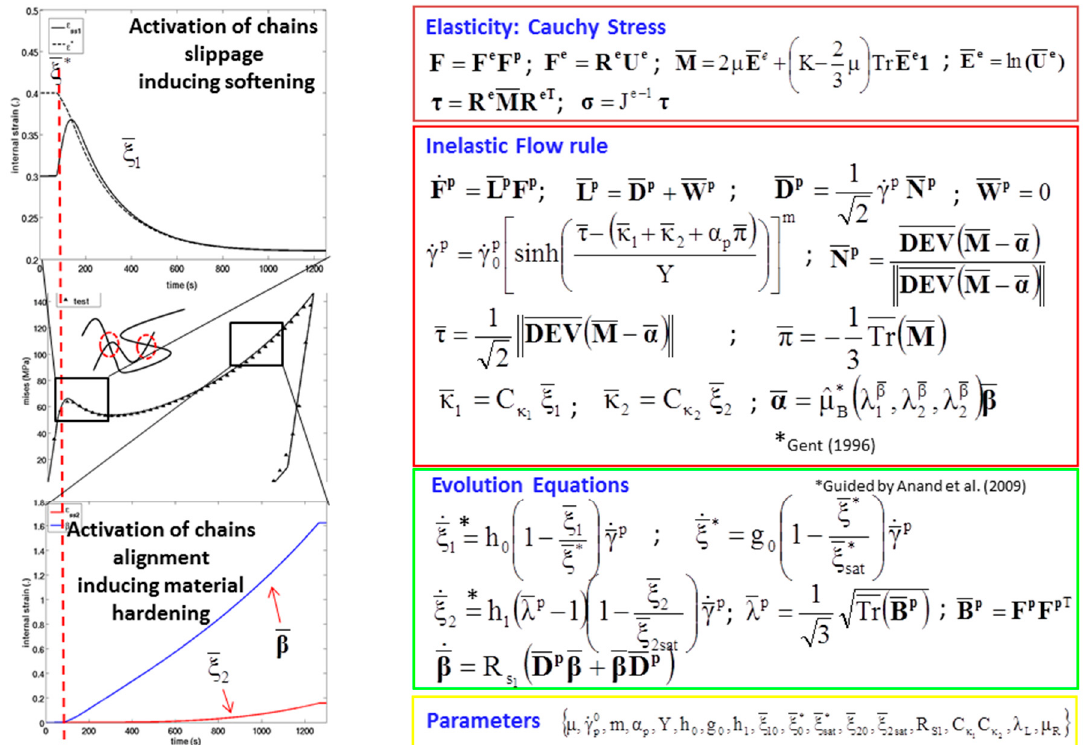
Figure A1. Overview of the material model, MSU TP Ver. 1.1, with salient features of the flow rule and evolution equations [40].